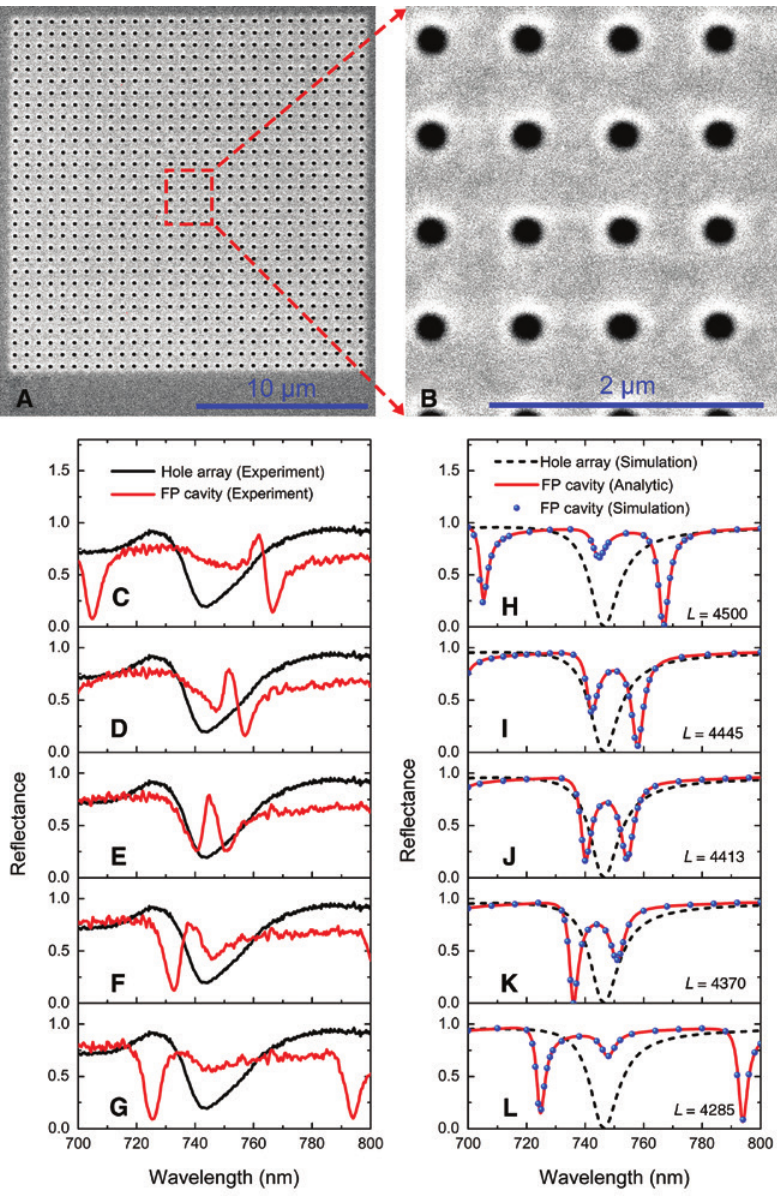
Figure 3: (A) SEM image of the metallic nanohole array. (B) Zoomed-in SEM image of the nanohole array. (C–G) Measured reflection spectra of the FP cavity (red solid lines) at different cavity lengths. The black solid line is the measured reflection spectrum of the metallic nanohole array. Simulation and analytic results of the reflection spectra of the FP cavity at different cavity lengths of (H) L = 4500 nm, (I) L = 4445 nm, (J) L = 4413 nm, (K) L = 4370 nm, and (L) L = 4285 nm. The black dashed lines denote the reflection spectrum of the metallic nanohole array. The red solid lines are the analytic results, and the blue dots are the simulation